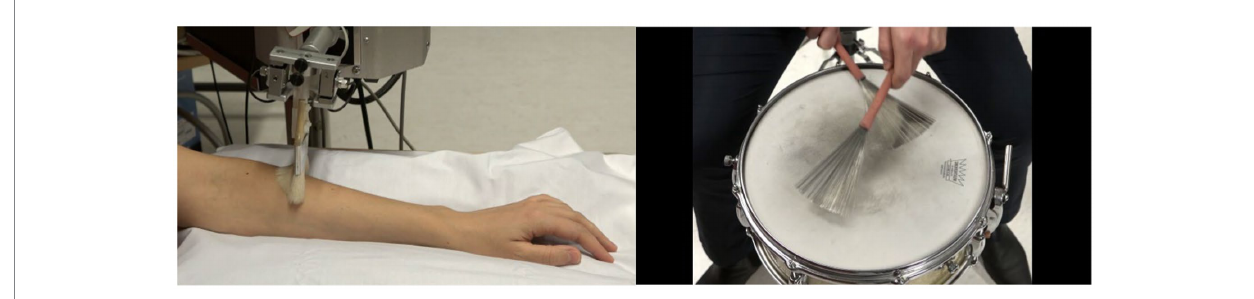
FIGURE 8 Still frames from videos of ‘arm brushing (left) and ‘drum brushing’ (right)